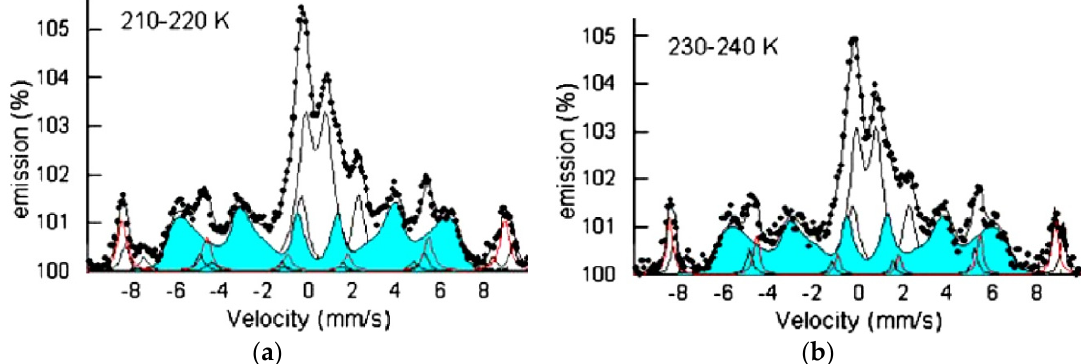
Figure 48. Mössbauer spectra of rock “Clovis” in the Columbia Hills at the Gusev Crater, Mars, measured at two temperature ranges: 210–220 K ( a ) and 230–240 K ( b ). Indicated spectral components are the results of the fits. Adapted from [139].